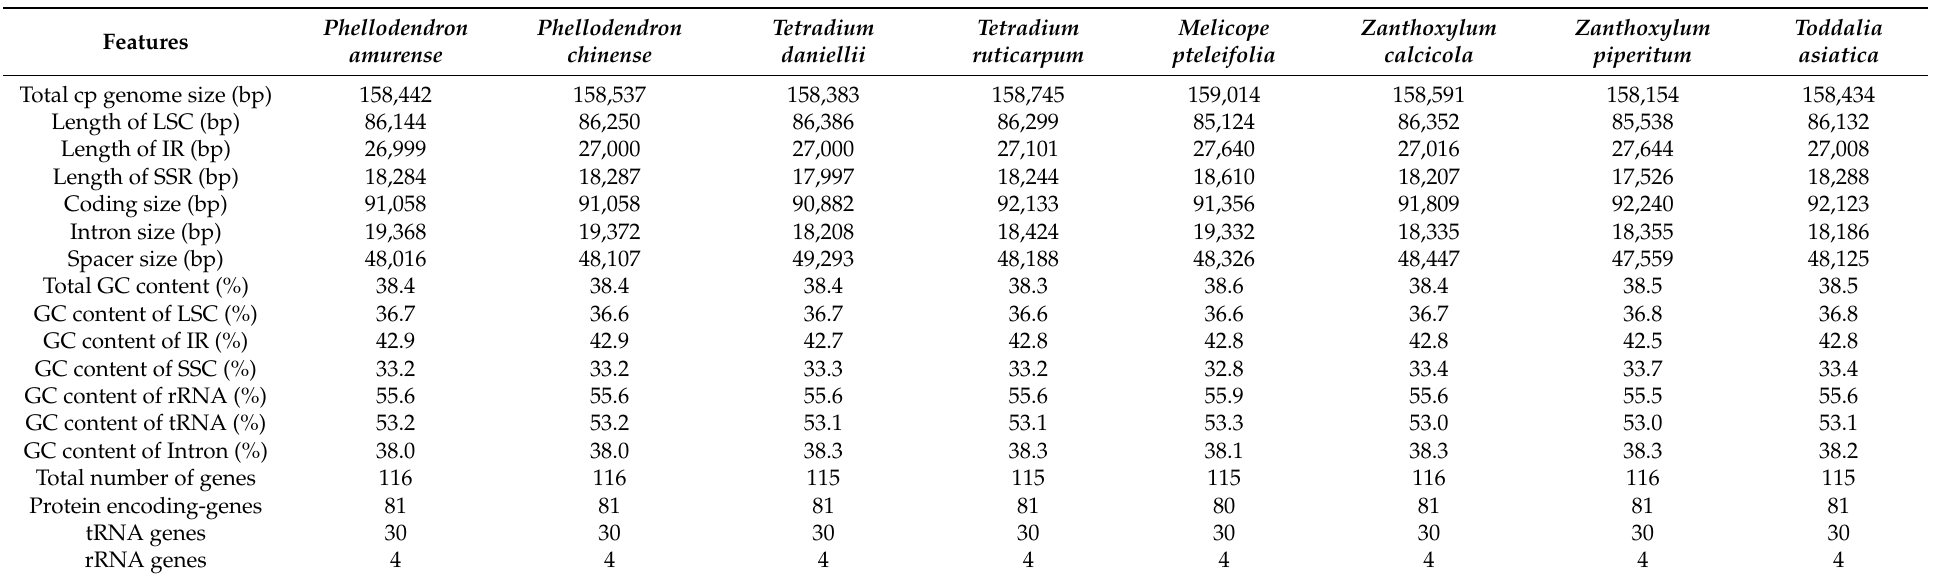
Table 1. General features of the eight chloroplast genomes compared in this